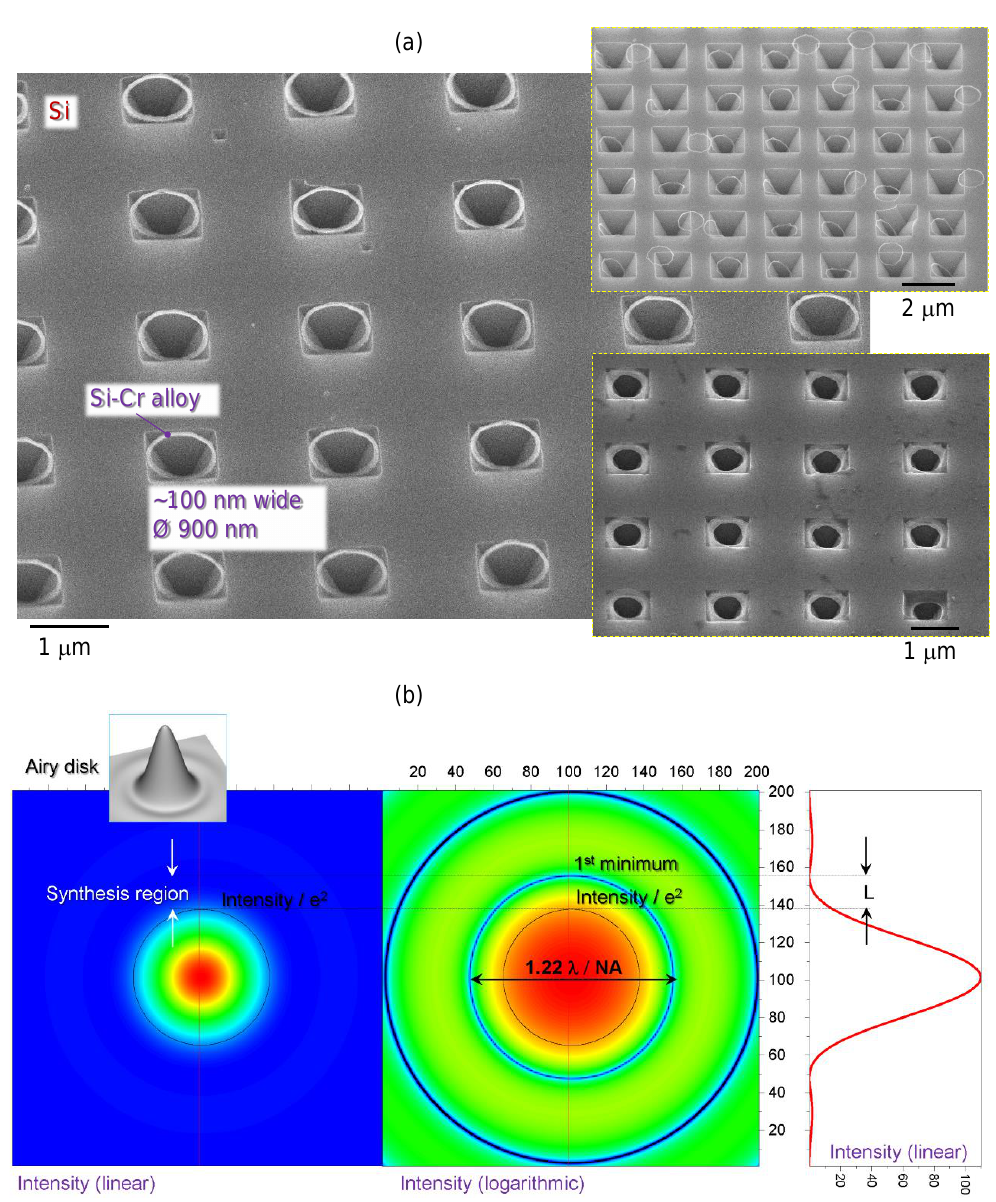
Figure 4. ( a ) SEM image of Si-Cr alloy ring formed at the rim of ablated pit in the Cr mask; imaged after KOH etch of Si (inverted pyramids are formed) and Cr-etch removal of the laser unexposed regions of Cr. Insets shows conditions of KOH over-etch when opening of the pyramidal pit becomes larger as diameter of the ring. ( b ) Intensity distribution of a plane wave at the focus in linear and logarithmic scale; the inset shows a 3D envelope of the intensity profile